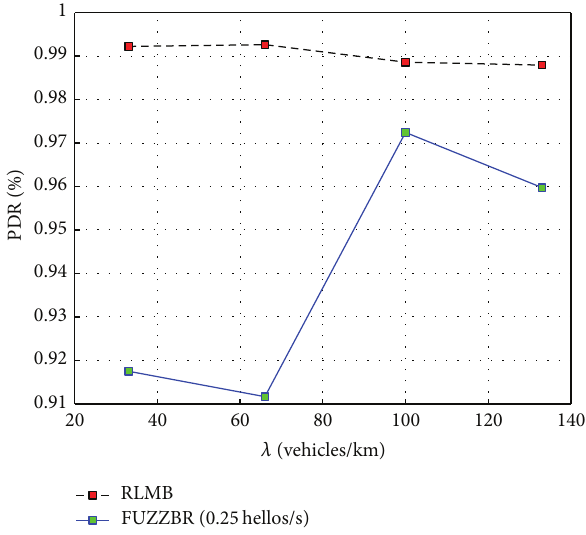
Figure 9: Packet delivery ratio (PDR) obtained with RLMB (0.25 hps) and FUZZBR (0.25 hps) when increasing the vehicles density, 𝜆